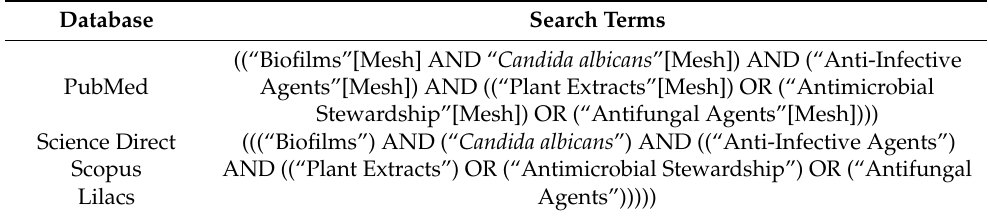
Table 6. Search strategy used in each